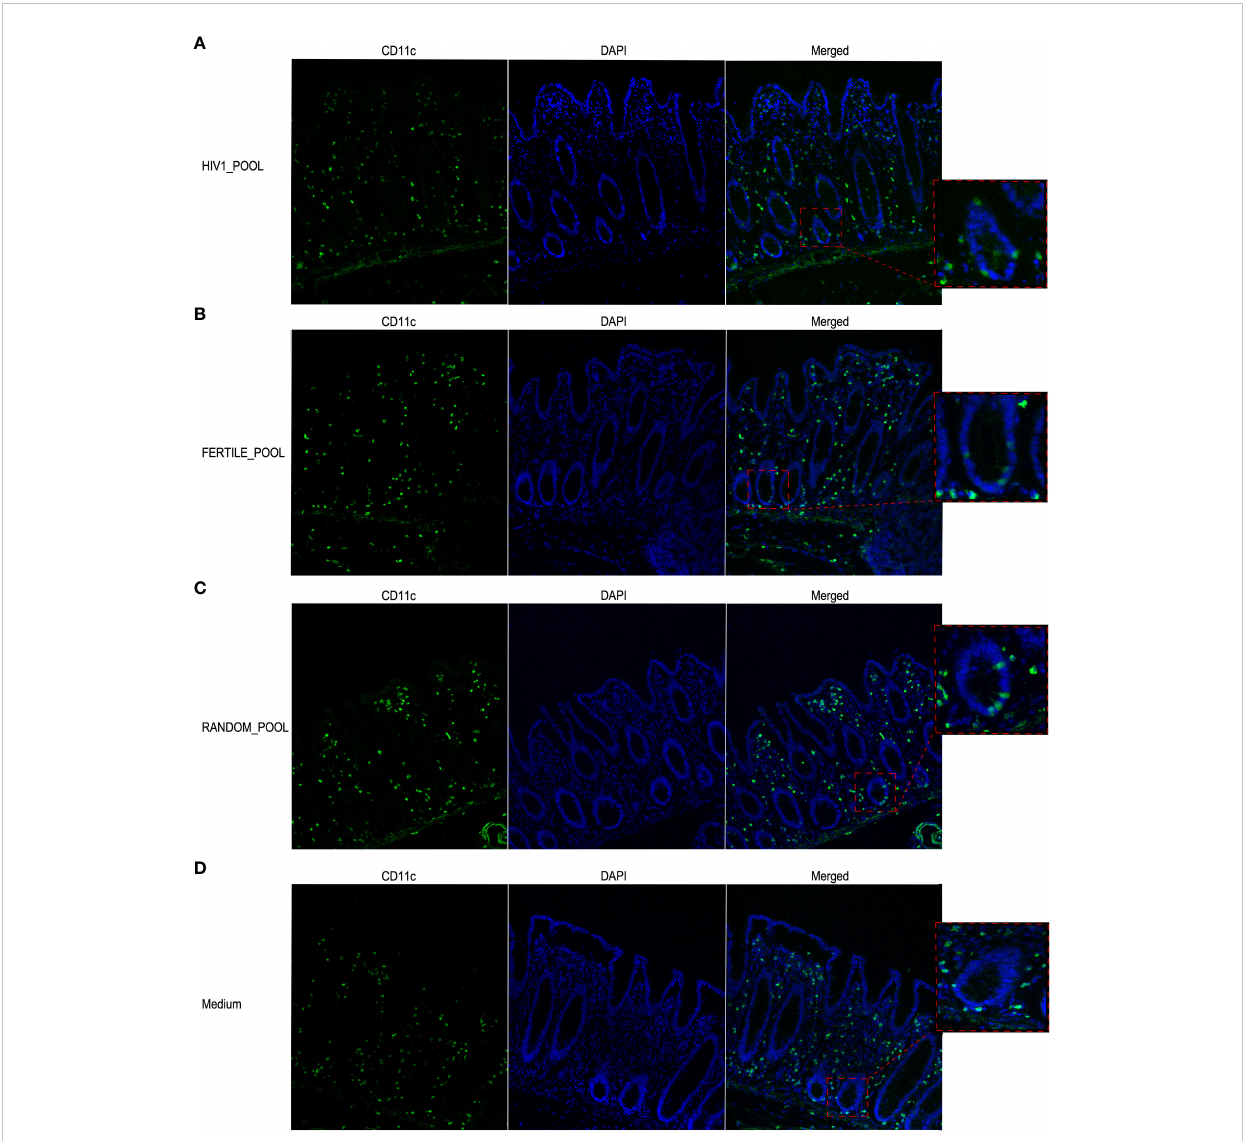
FIGURE 6 HSP recruits CD11c+ MNP cells within the intestinal epithelial layer. Representative images of CD11c+ cells localization in colonic mucosa stimulated with HSP pooled from HIV positive panel (A) , fertile panel (B) , randomly selected donors panel (C) or medium control panel (D) . Magni fi cation of selected regions showing intraepithelial cells in A-C and subepithelial cells in D is shown in the boxed areas. Cells were stained with a rabbit anti human CD11c mAb followed by Alexa Fluor 488-conjugated goat anti-rabbit IgG antibody (green). DAPI stained the nuclei